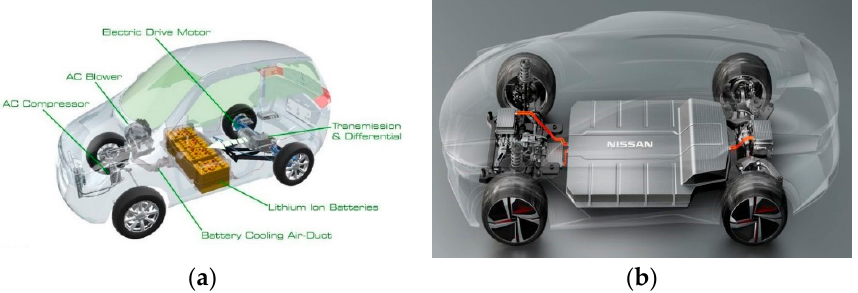
Figure 4. ( a ) Mahindra E20 with rear wheel drive with single motor using single speed transmission ( b ) all-wheel drive Nissan IMX.